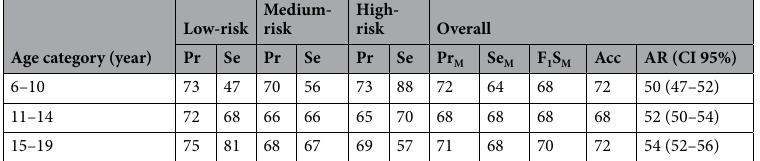
Table 6. The performance of the GMDH algorithm (in percent) based on the cross-validated confusion matrix for classifying extended three-class psychiatric symptoms. Pr Precision, Se Sensitivity, Acc